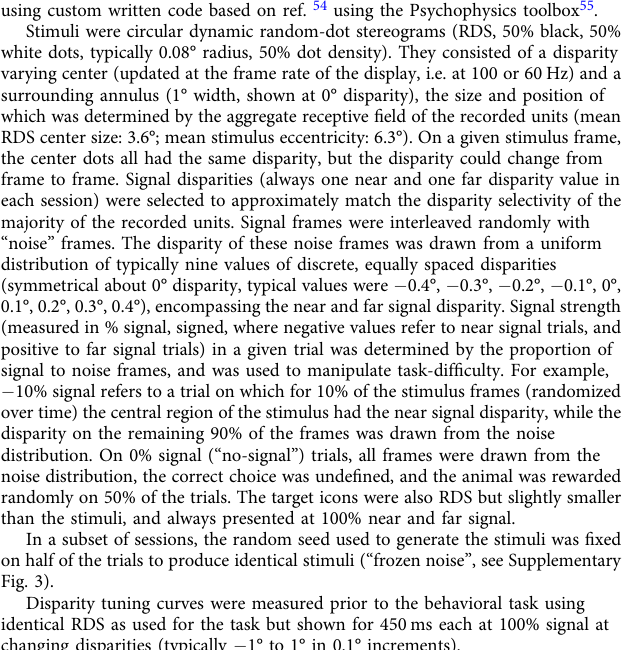
circular polarizing fi lters. Visual stimuli were generated in Matlab (Mathworks) using custom written code based on ref. 54 using the Psychophysics toolbox 55 . Stimuli were circular dynamic random-dot stereograms (RDS, 50% black, 50% white dots, typically 0.08° radius, 50% dot density). They consisted of a disparity varying center (updated at the frame rate of the display, i.e. at 100 or 60 Hz) and a surrounding annulus (1° width, shown at 0° disparity), the size and position of which was determined by the aggregate receptive fi eld of the recorded units (mean RDS center size: 3.6°; mean stimulus eccentricity: 6.3°). On a given stimulus frame,